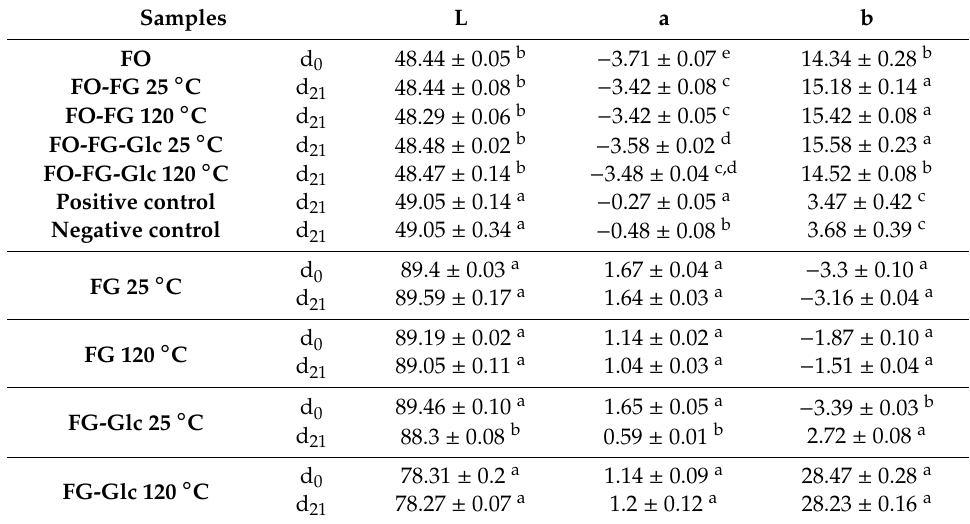
Table 2. Color parameters of flaxseed oil, FG and FG-Glc pouches at the initial time (d 0 ) and at 21 days after application (d 21